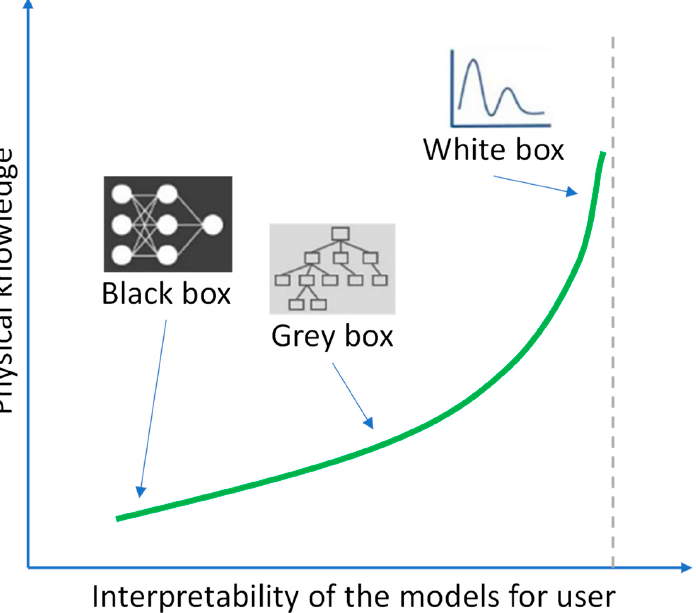
Figure 1. Classification of the AI modeling techniques (adapted from Giustolisi et al. [63] and Figure 1. Classi fi cation of the AI modeling techniques (adapted from Giustolisi et al. [63] and Zhang Zhang et al. et al. [64]).